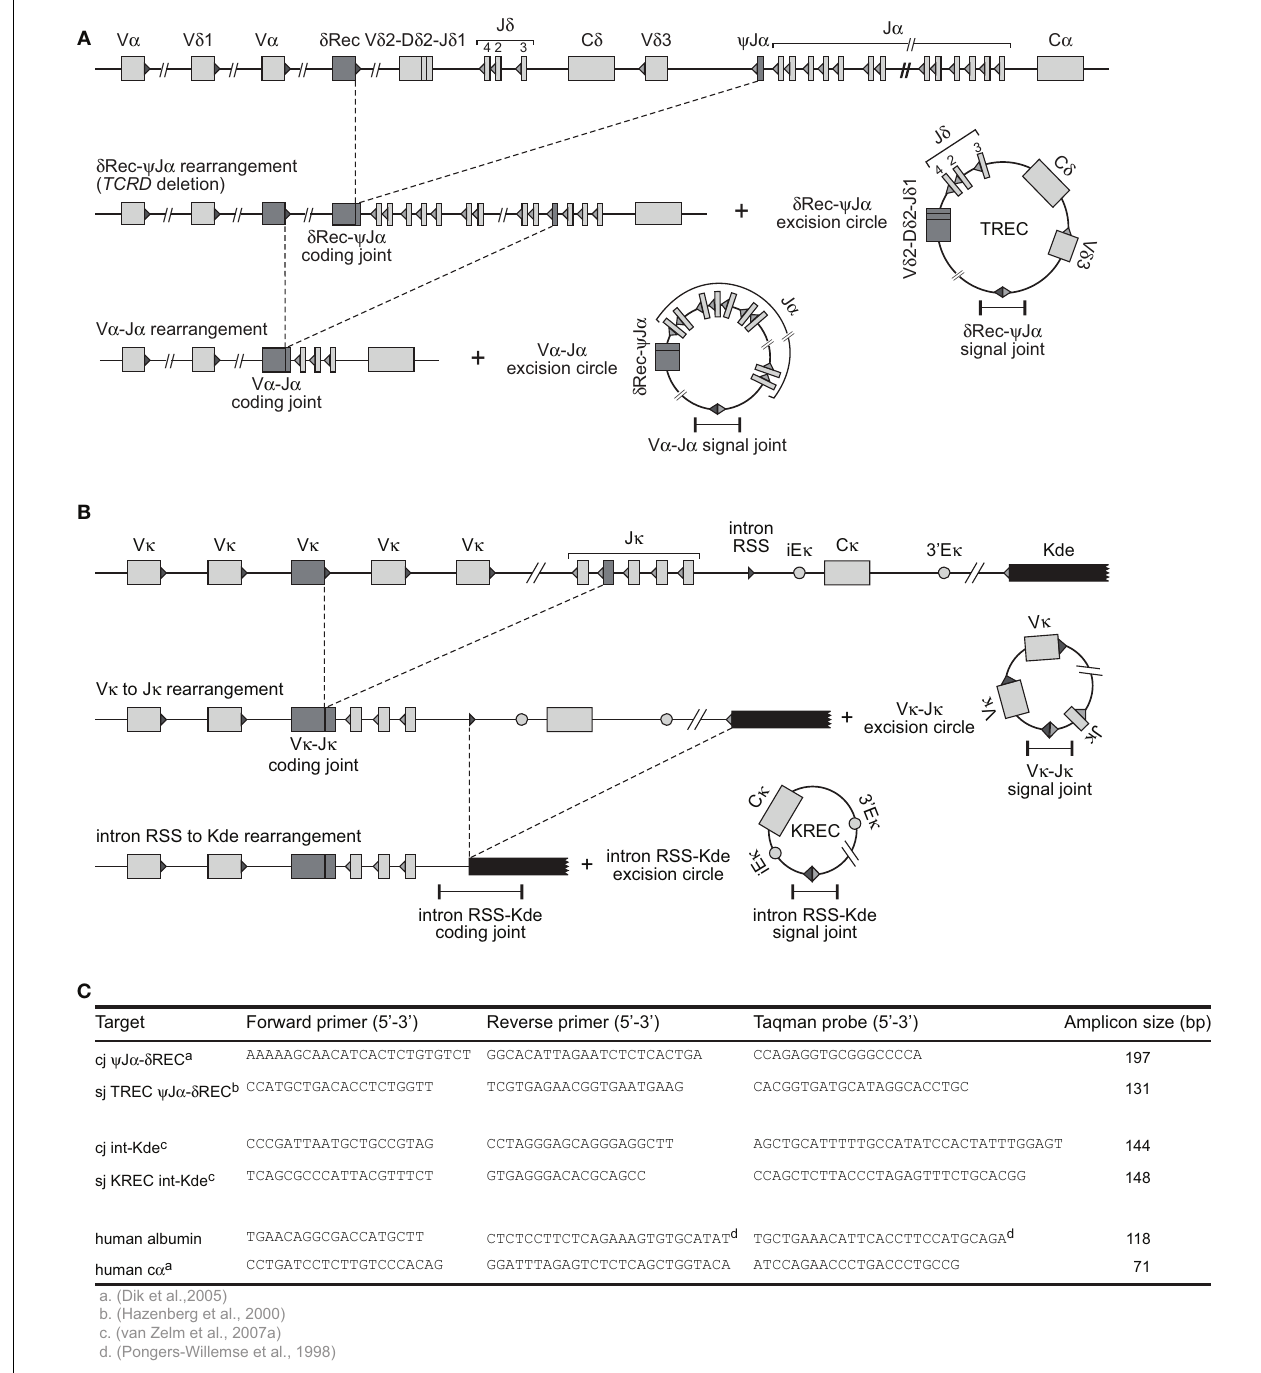
rearrangement between the intronRSS and the Kde elements can render the IGK allele non-functional by deleting the C κ exons and the enhancers. Consequently, the coding joint precludes any further rearrangements in the IGK locus and therefore remains present in the genome, whereas an intronRSS–Kde signal joint is formed on an excision circle (KREC). (C) Oligonucleotide characteristics forTREC, KREC, and control gene quantification (Pongers-Willemse et al., 1998; Hazenberg et al., 2000; Dik et al., 2005; van Zelm et al.,